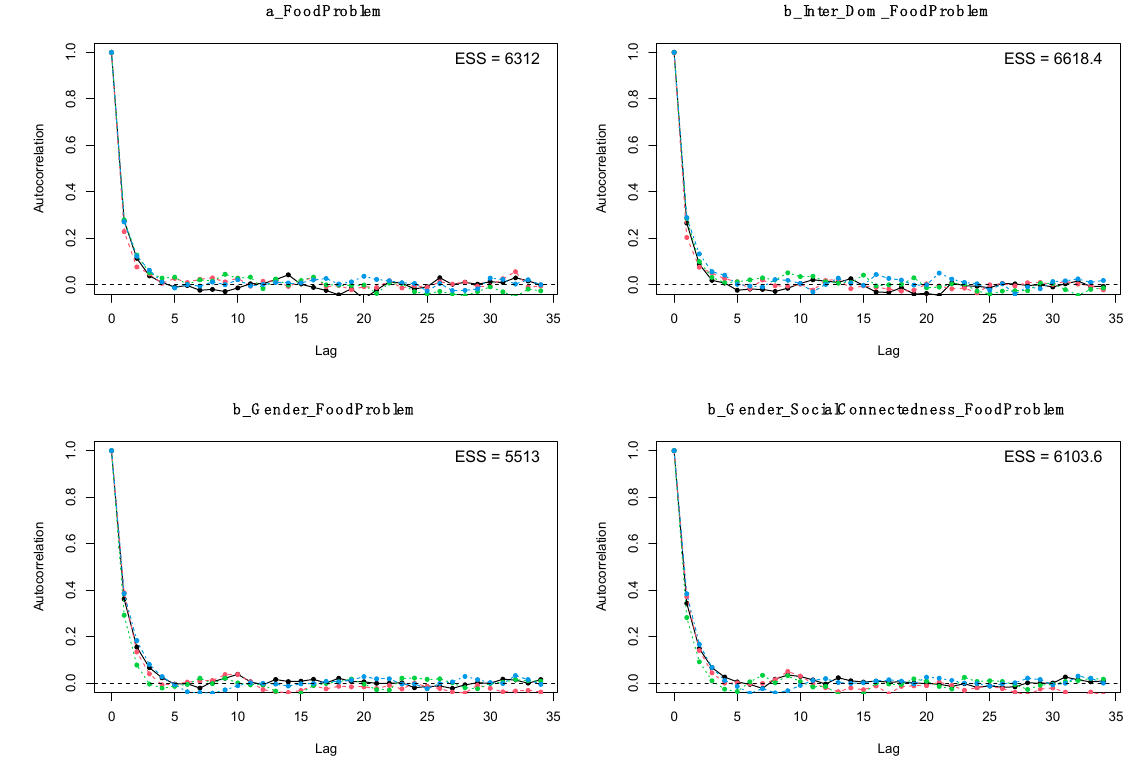
Figure 4. Gelman plots for the model’s posterior coefficients.